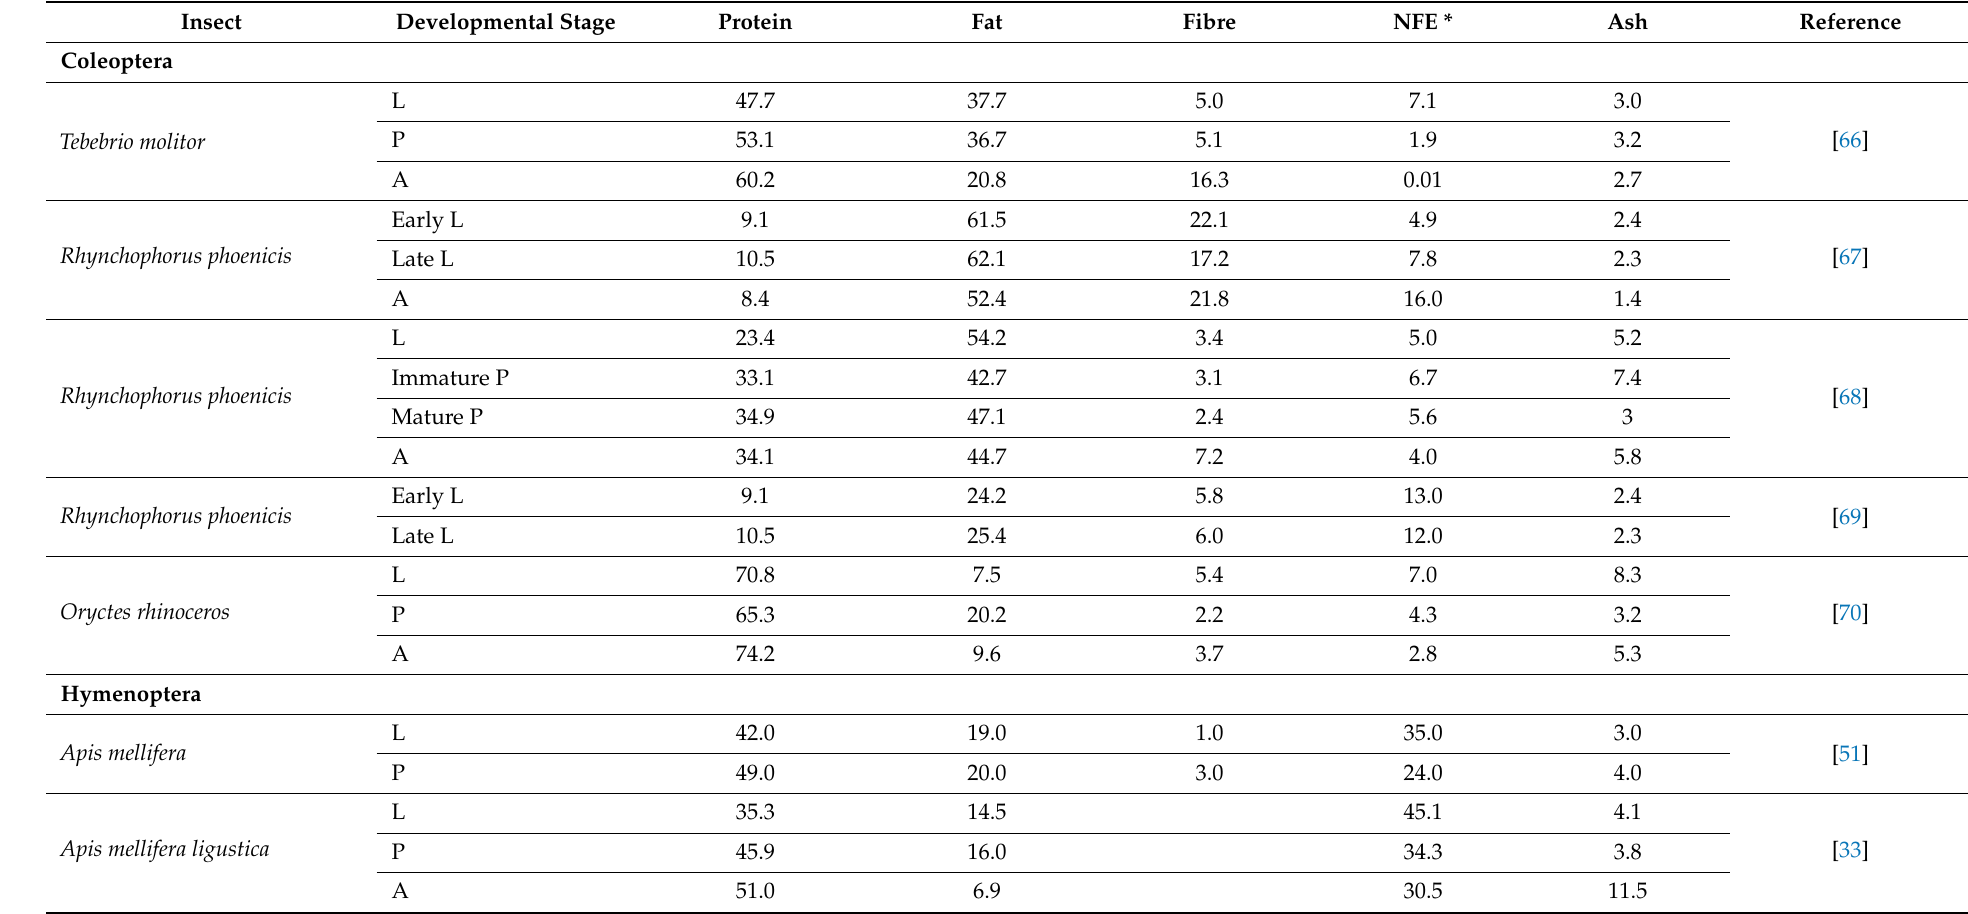
Table 6. Comparative account of proximate nutrient content (g/100g dry matter basis) of different developmental stages of edible insects. Insect Developmental Stage Protein Fat Fibre NFE * Ash